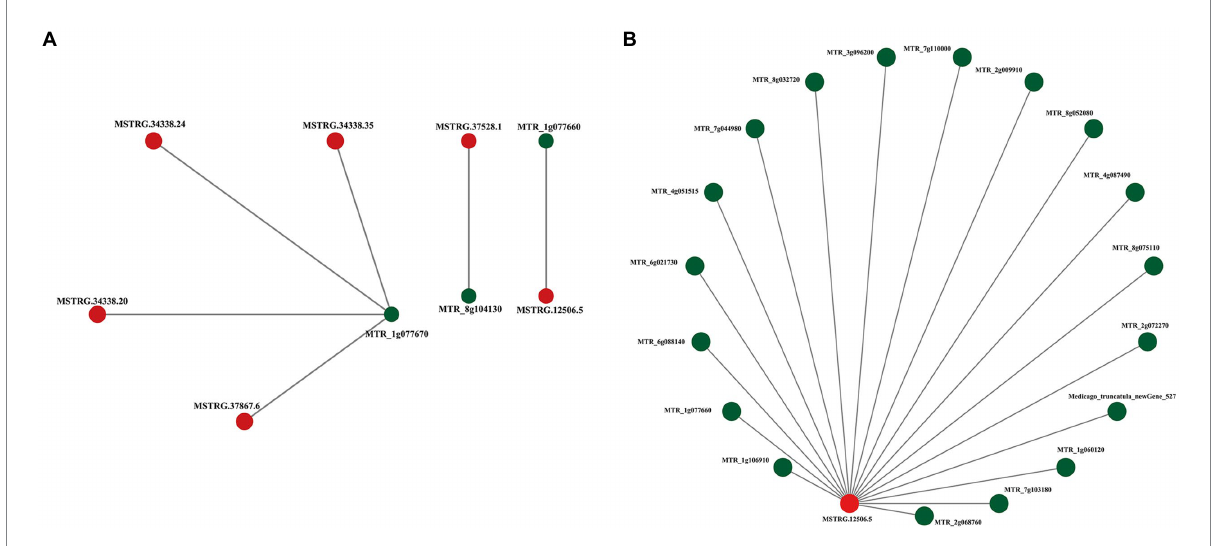
FIGURE 4 Representatives of predicted interaction networks among ALMT-related lncRNAs and protein-coding RNAs. (A) Interaction network of MTR_1g077670. (B) Interaction network of MSTRG.12506.5. The lncRNA and mRNA nodes are colored red and green,